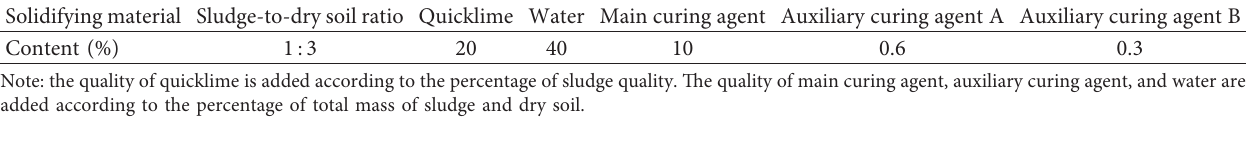
Table 3: Preparation scheme of municipal sludge solidified soil.